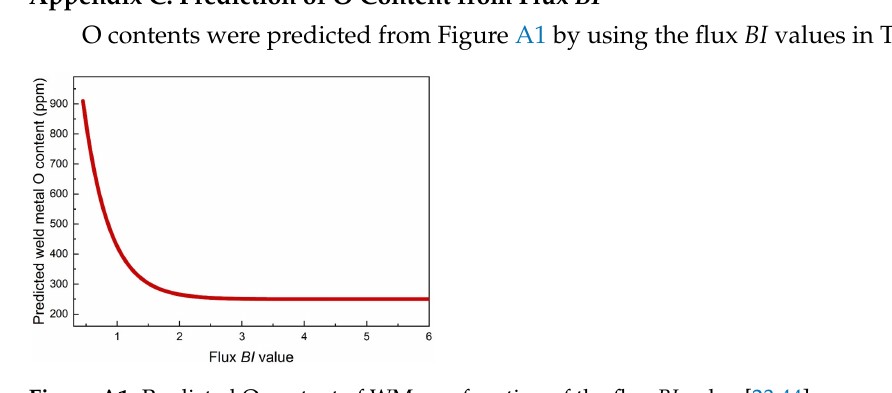
Figure A1. Predicted O content of WM as a function of the flux BI value [23] .